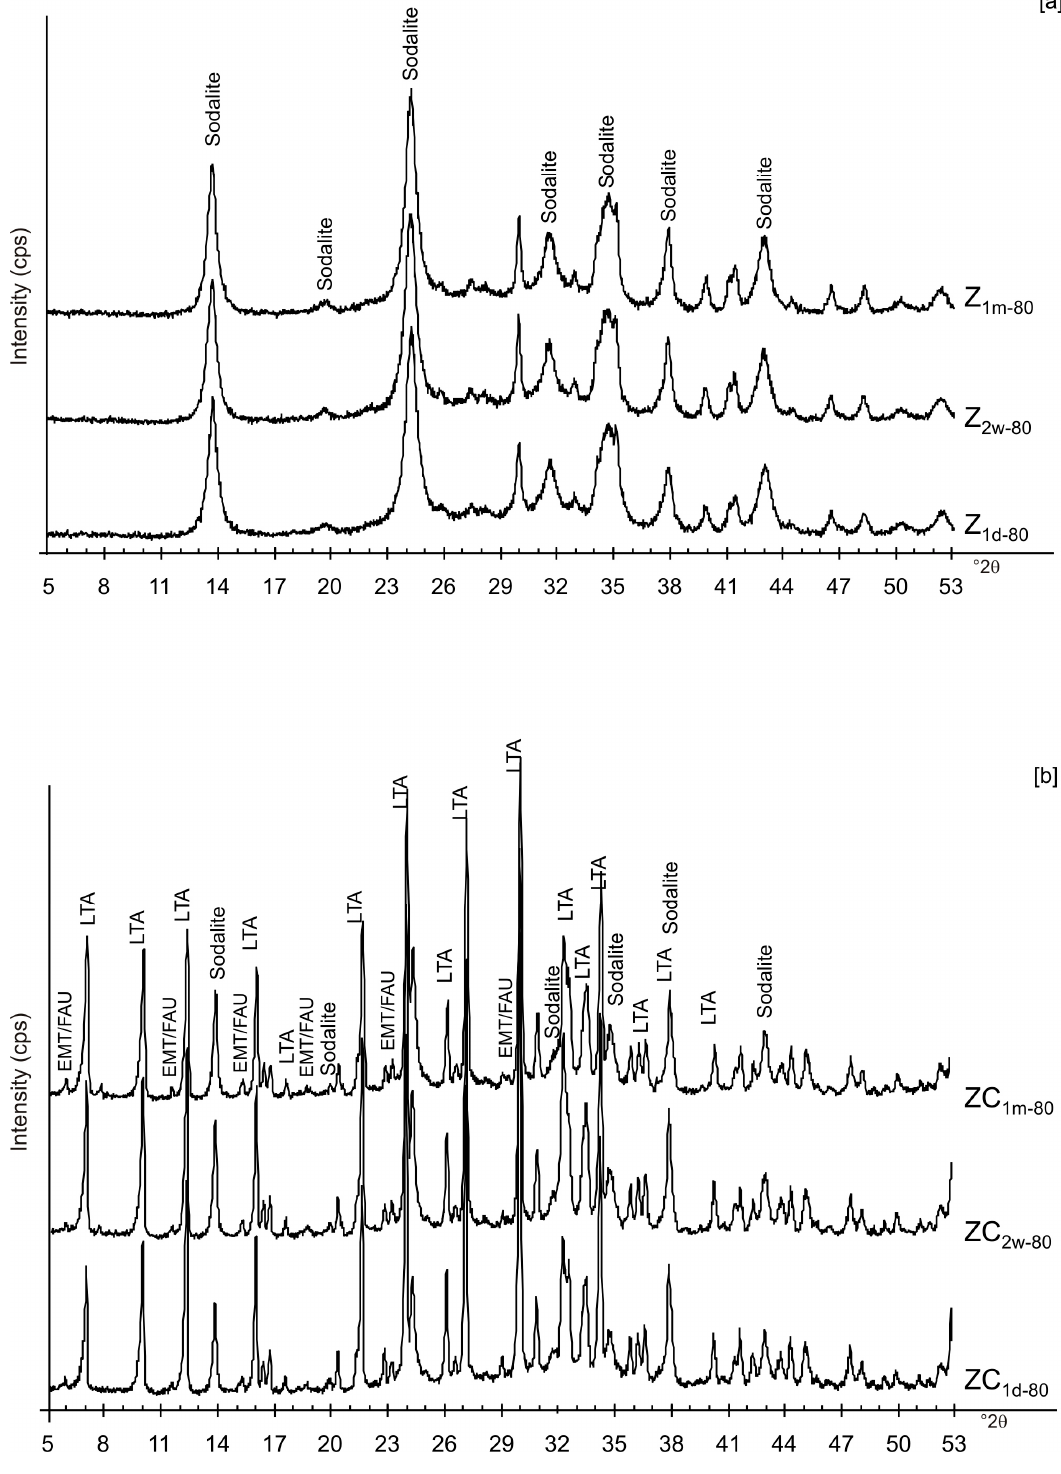
Figure 10. X-ray diffraction profiles of Z ( a ) and ZC ( b ) dried at 80 °C. Figure 10. X-ray di ff raction profiles of Z ( a ) and ZC ( b ) dried at 80 ◦ C. The right-most column in Table 1 summarizes the mineralogical composition of each synthetic